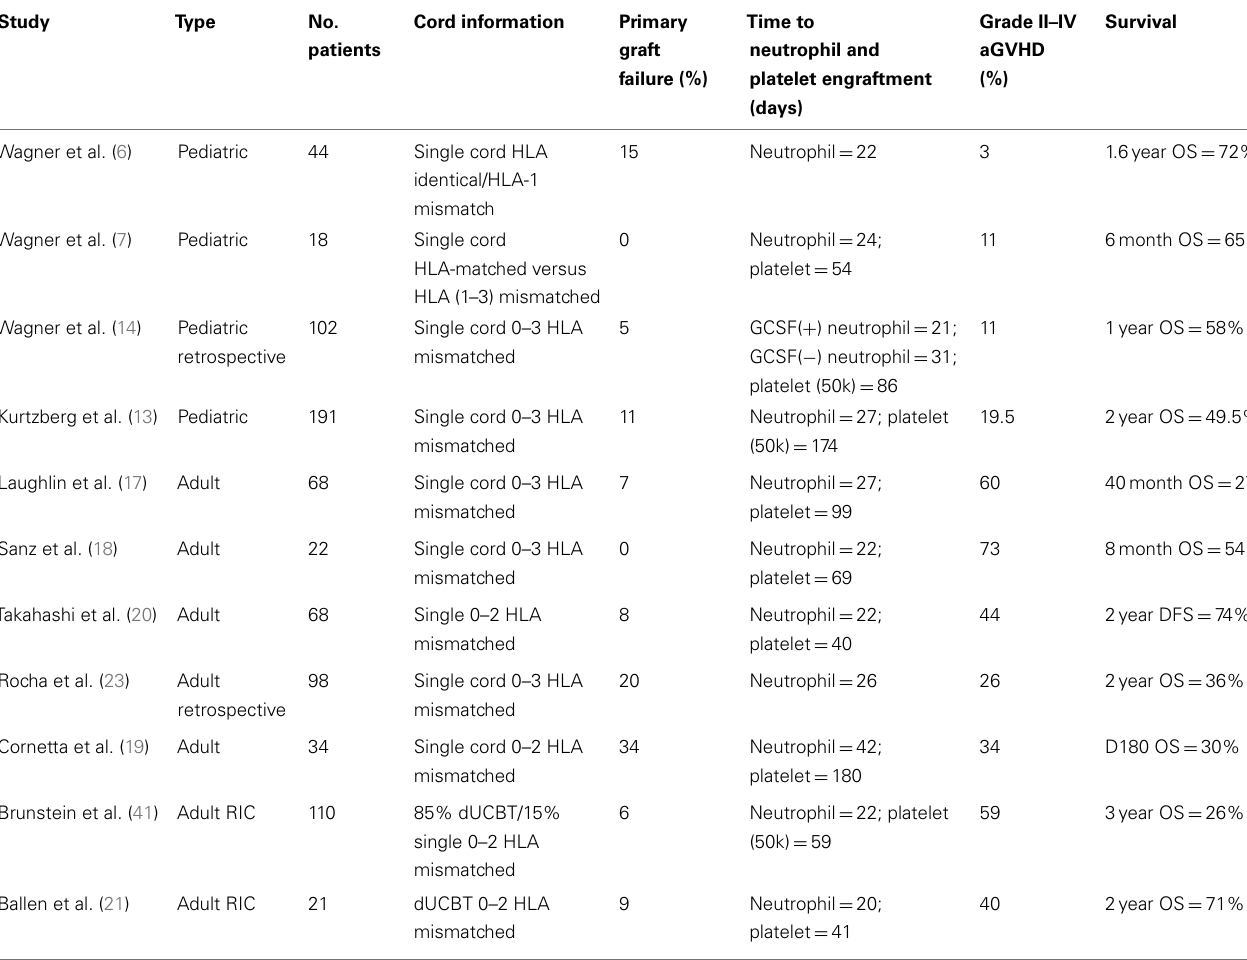
Table 1 | Comparison of multiple UCBT studies, including both pediatric and adult patients and single UCBT and